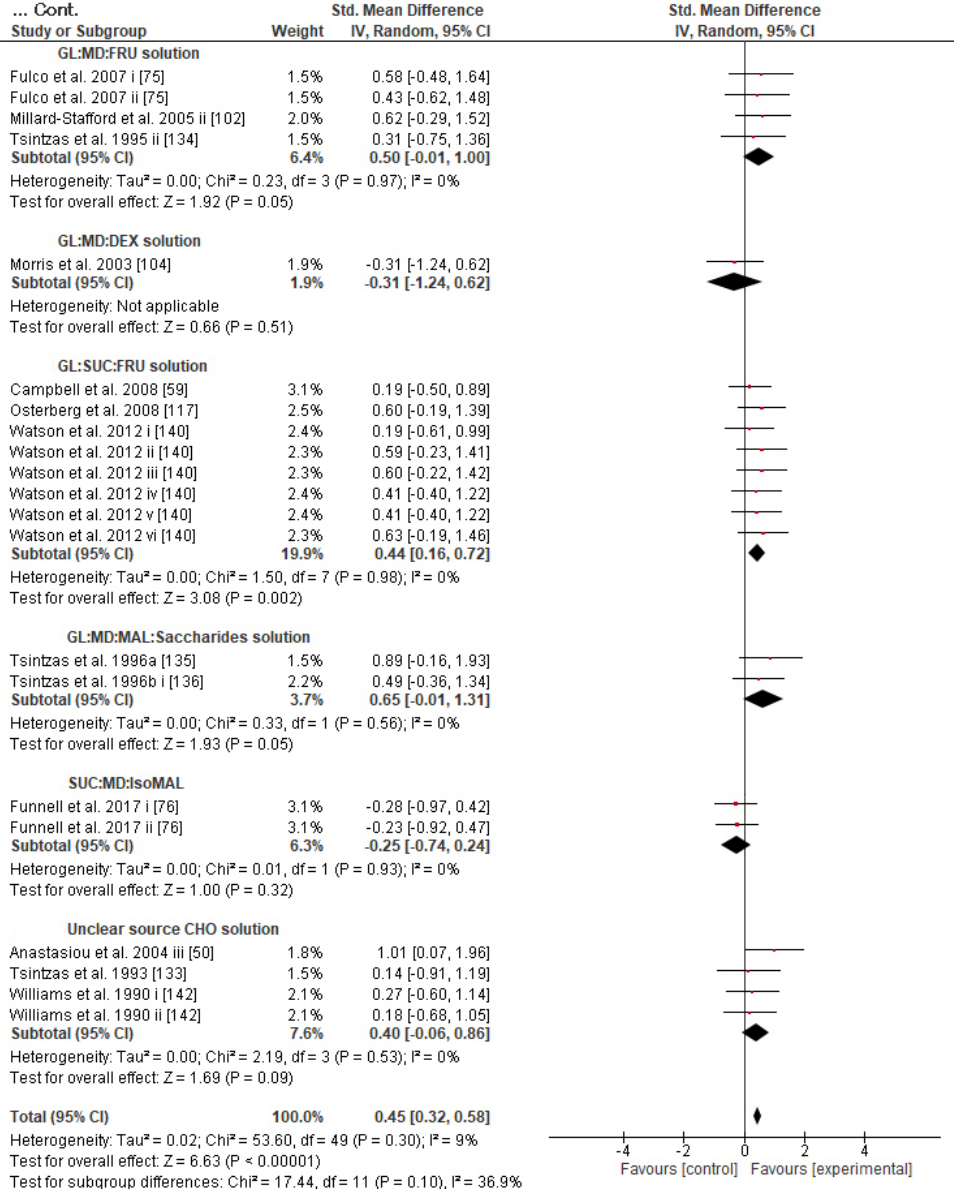
Figure 5. Forest plot shows the effects (red square symbol) of experimental carbohydrate supplemen- tation as compared to a control on exercise outcome for 50 interventions